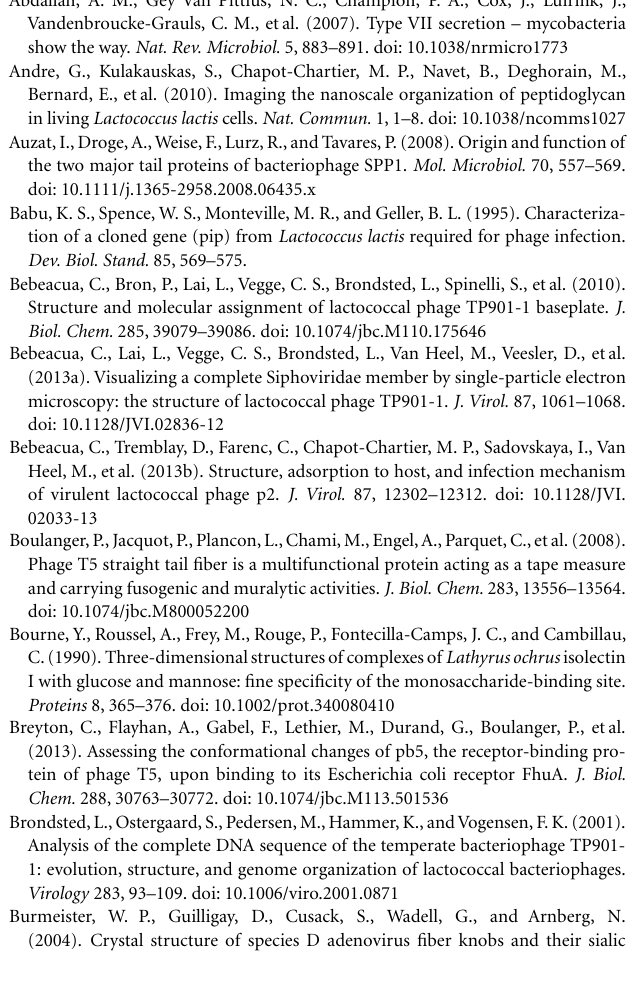
baseplate and the specific pellicle, leading, in the presence of Ca ++ to (D) baseplate activation, RBPs rotation, and strong binding involving several of the 18 saccharide binding sites. Figure taken from Bebeacua etal. (2013b). Copyright © American Society for